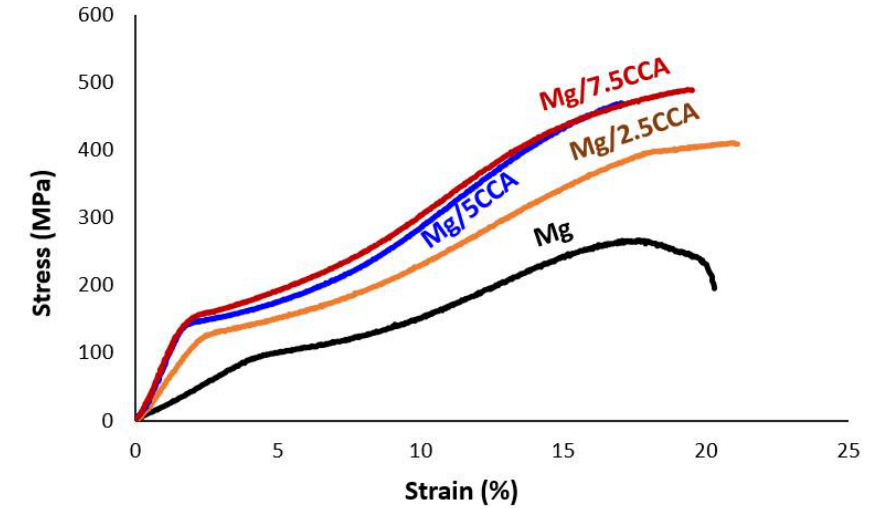
Figure 6. Compressive Stress-Strain curve of the Mg and Mg-CCA composites.